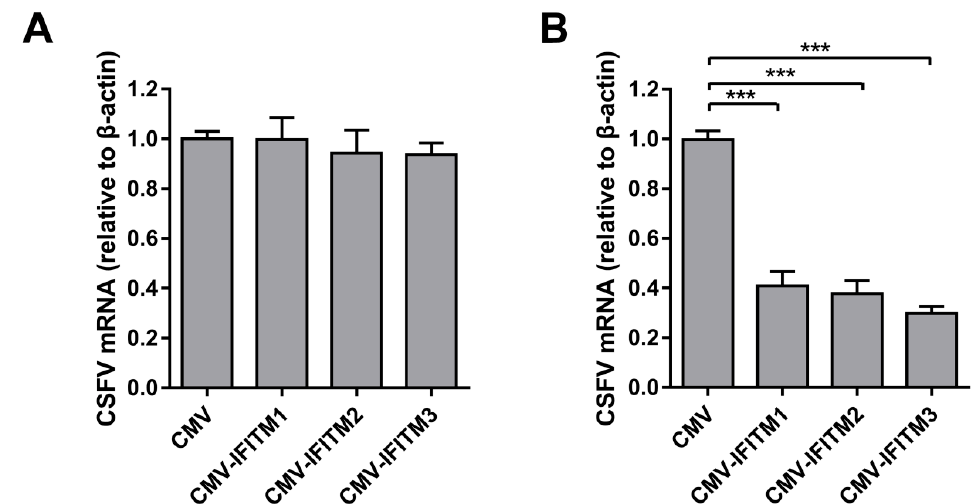
Figure 6. IFITMs do not interfere with CSFV binding but restrict CSFV entry. ( A ) Virus binding assay. PAMs were inoculated with CSFV at an MOI of 1 for 1 h at 4 ◦ C. After washing with ice-cold phosphate-buffered saline (PBS), cell-bound CSFV was quantified by RT-qPCR. Data were normalized to β -actin expression. ( B ) Entry assay. PAMs were inoculated with CSFV at an MOI of 1 for 1 h at 4 ◦ C. The viral inoculum was removed, and cells were washed with ice-cold PBS and then incubated with culture medium at 37 ◦ C. After 2 h, PAMs were treated with PBS containing proteinase K to strip the CSFV that remained on the cell surface. CSFV genomic RNA levels were determined by RT-qPCR. Data were normalized to β -actin expression. Data represent the mean ± SD of three independent experiments and were measured in technical duplicate. Comparisons between groups were performed by Student’s t test. *** p < 0.001.